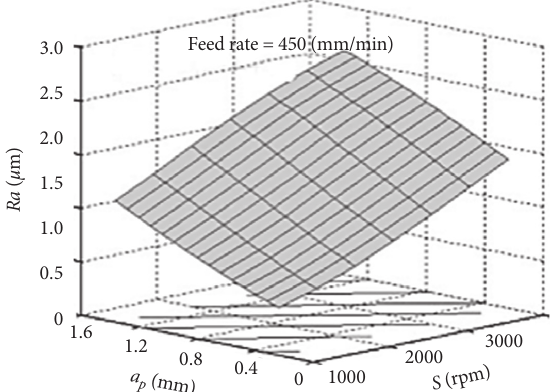
Figure 16: Result of spindle speed and doc on Ra for a constant feed rate of